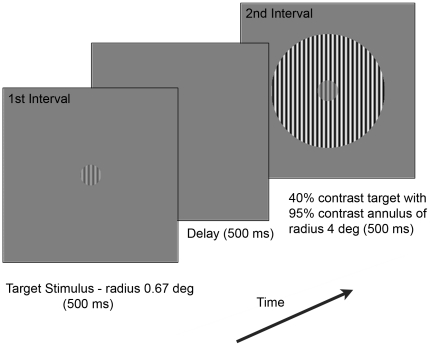
Schematic representation of the centre-surround contrast discrimination task.Consecutive stimuli were presented to participants who indicated which of the two intervals had the centre stimulus of higher contrast. The target stimulus (front panel) was presented for 500 ms followed by a 500 ms inter-stimulus interval. A second stimulus was then displayed for 500 ms and was comprised of either the target stimulus alone (no-surround condition) or surrounded by an annulus of 95% contrast with a radius of 4 degrees (surround condition – back panel). The smaller centre stimulus had a radius of 0.67 degrees and seven different contrast levels were randomly presented.